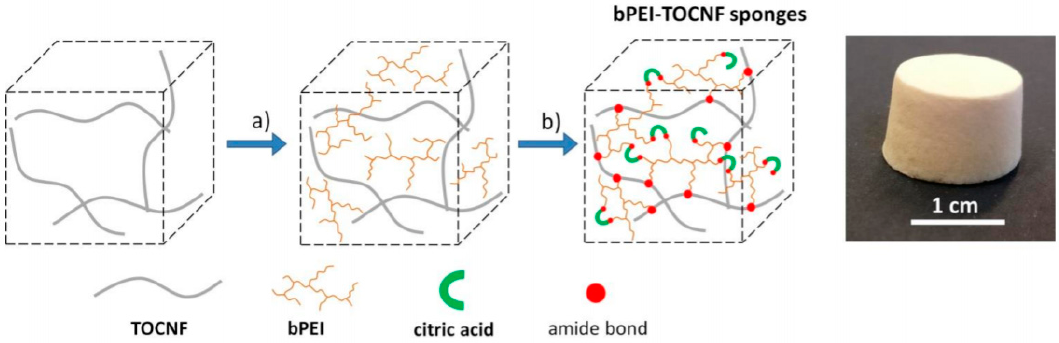
Figure 16. Preparation route of sponge-based TOCNFs via crosslinking of bPEI and TOCNFs with CA as a crosslinker; arrow ( a ) is cross-linking process, and arrow ( b ) is auxiliary carboxyl addition (this figure is reprinted with permission from ref. [193]. Copyright © 2017 Wiley-VCH Verlag GmbH & Co. KGaA, Weinheim.).